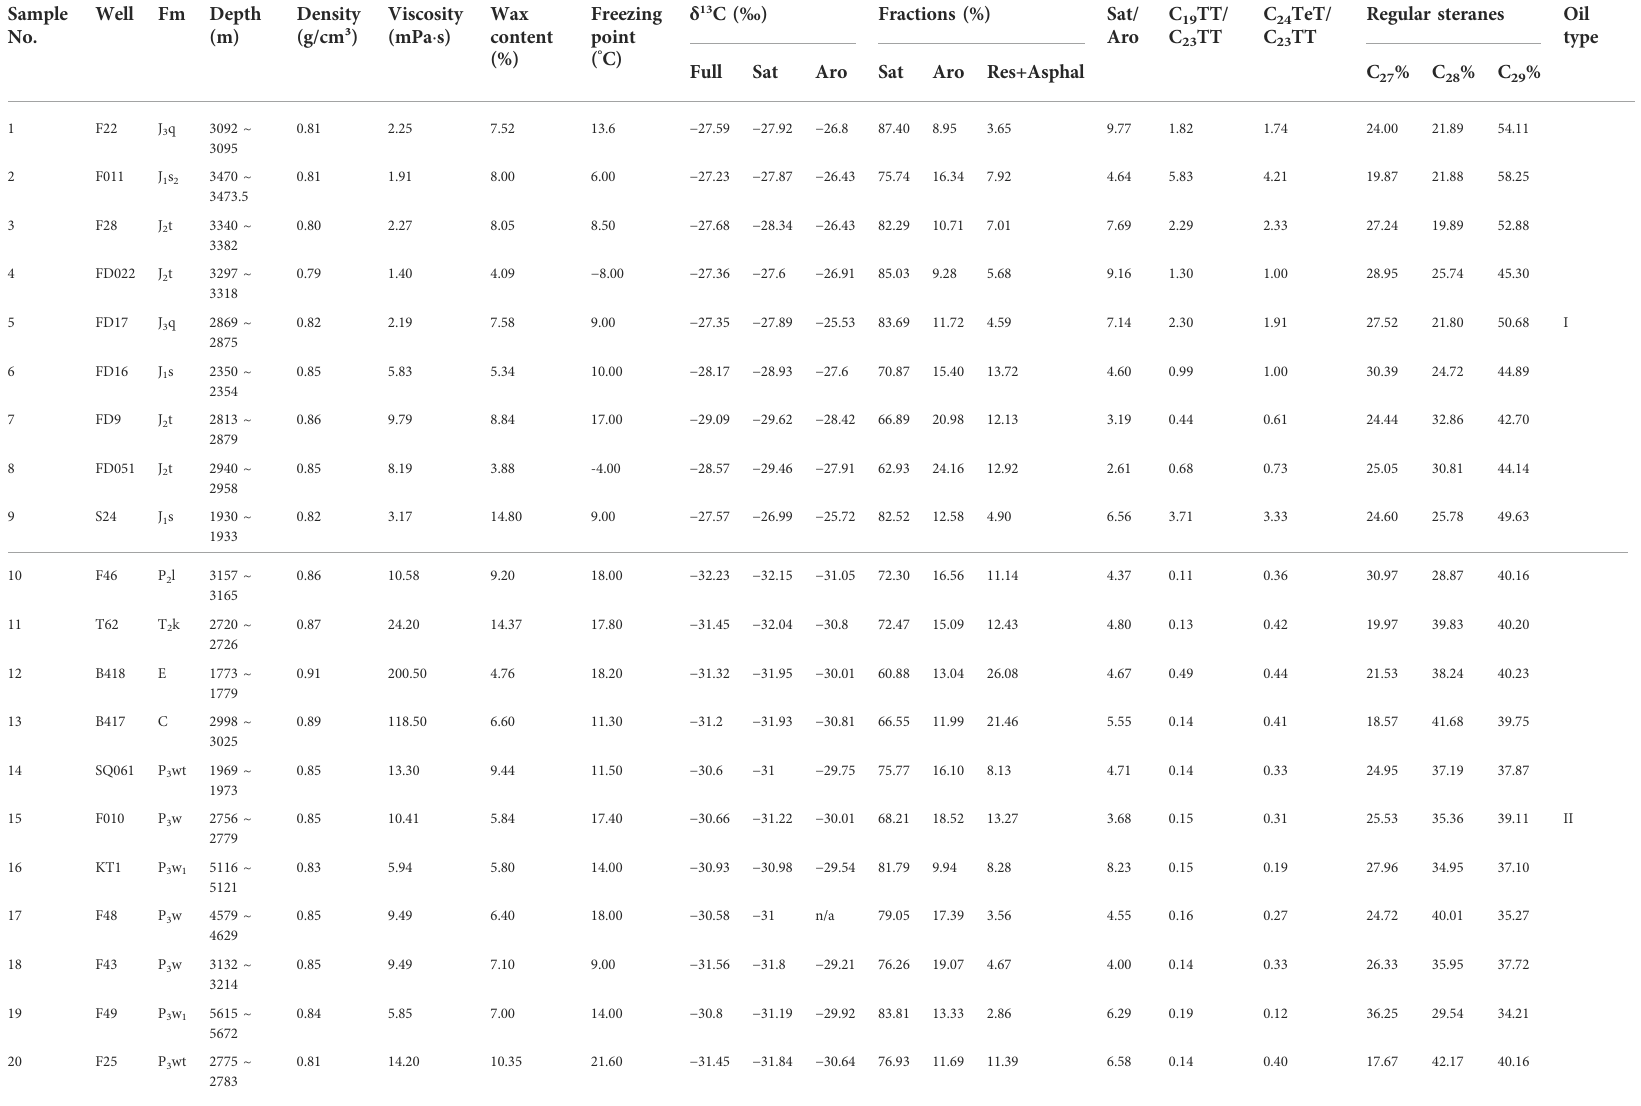
TABLE 1 Basic characteristics of crude oil in the East Fukang Sag. Sample